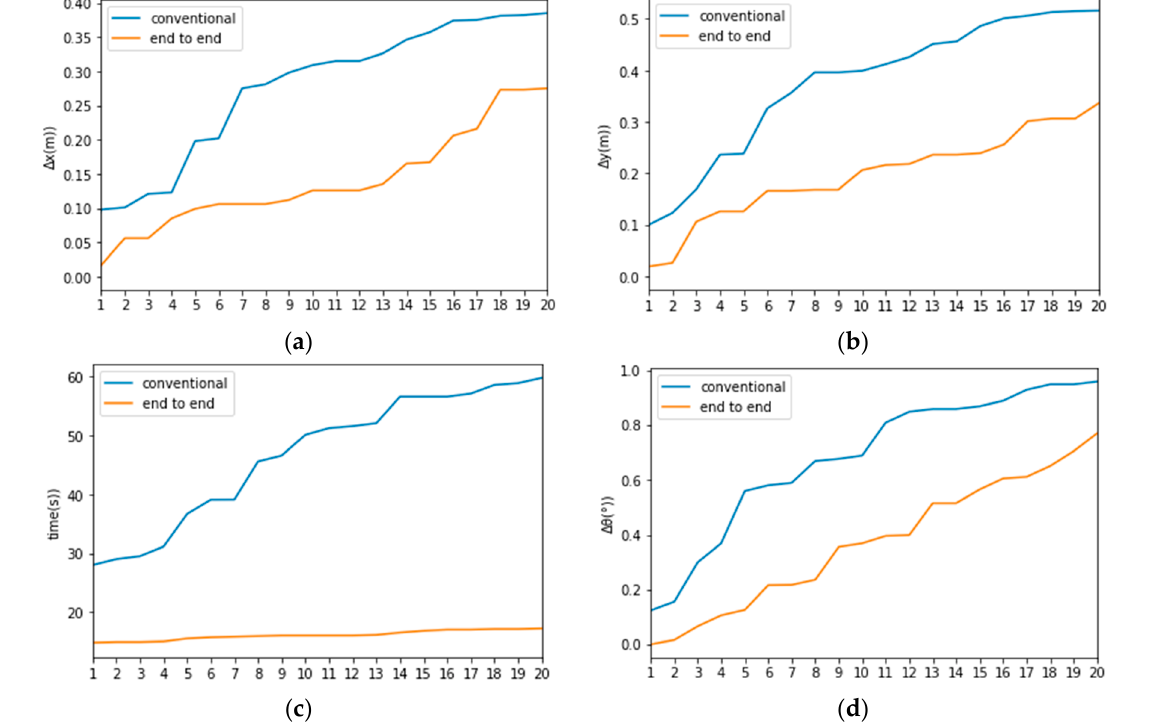
Figure 21. Comparison of 20 sets of parking data between conventional and end-to-end intelligent parking: ( a ) x; ( b ) y; ( c ) time; and ( d ) 𝜽 . parking: ( a ) x; ( b ) y; ( c ) time; and ( d ) θ